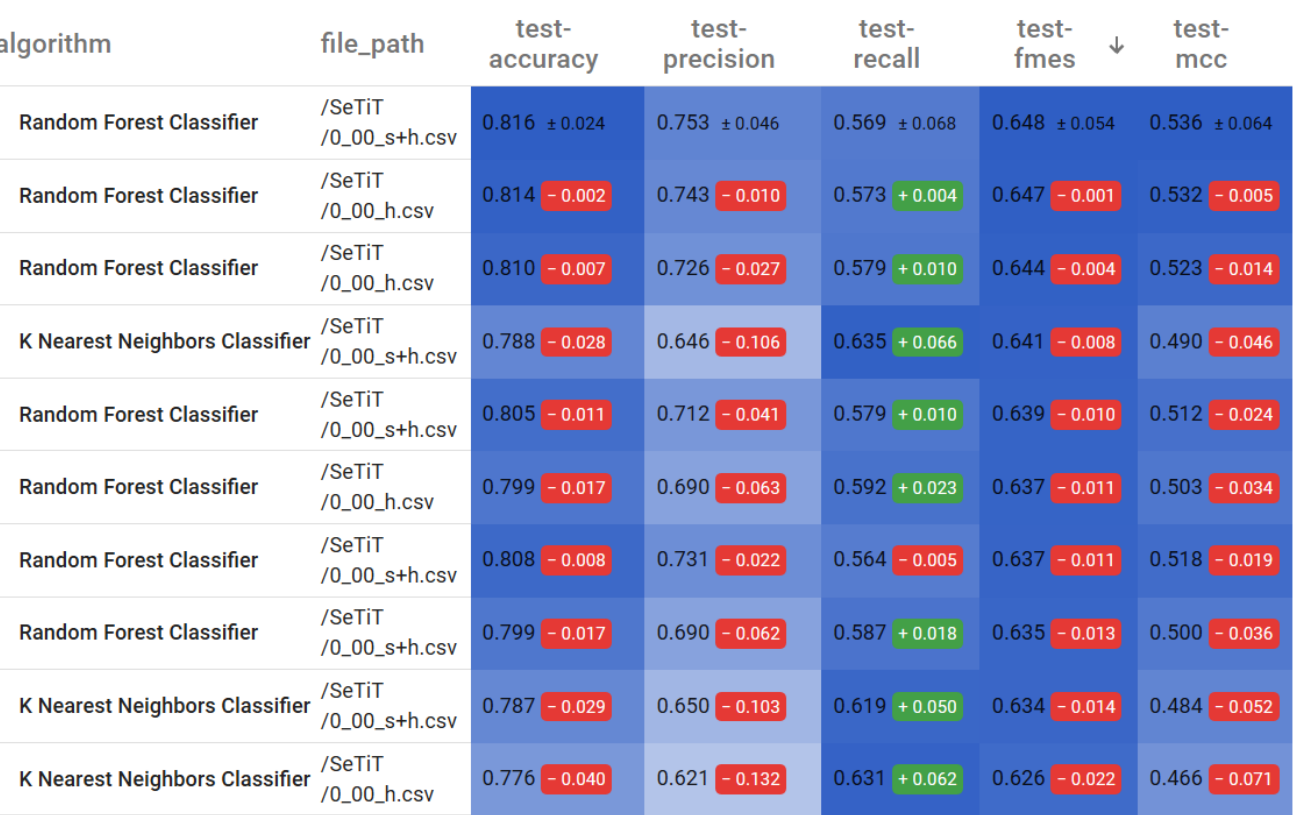
Figure 10. Top 10